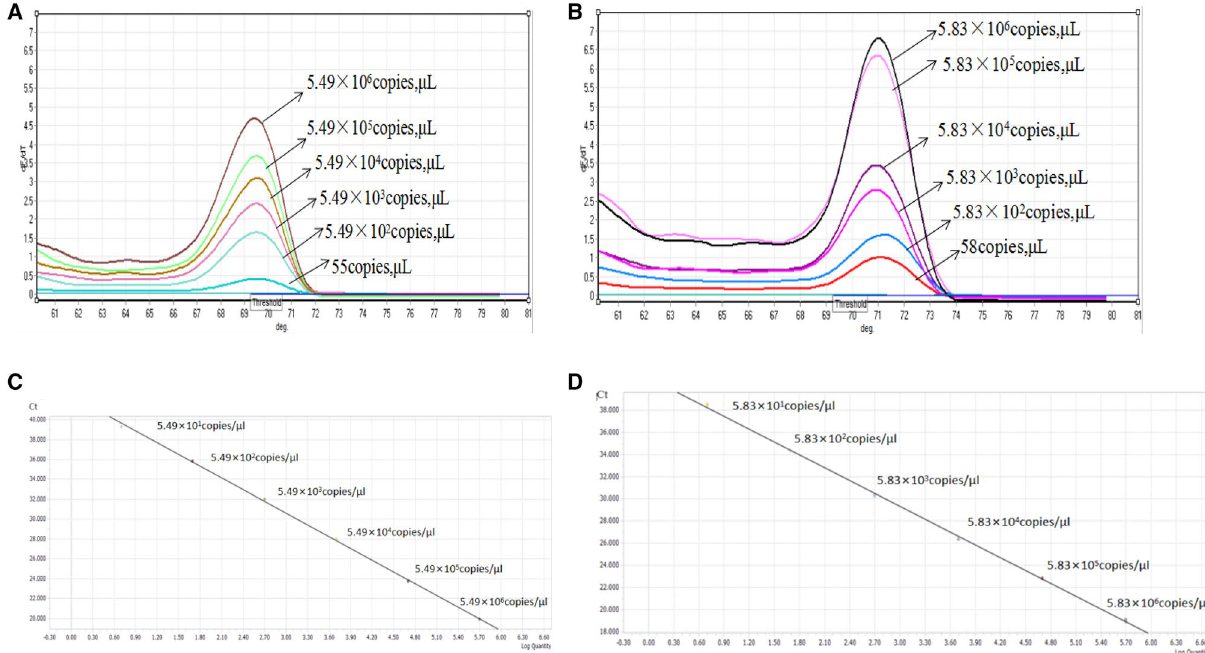
Figure 3. Sensitivity tests of the HRM method of Mccp and Mmc positive samples. The pictures are generated by Rotor Gene Q. ( A ) Sensitivity tests of the HRM method for Mccp ; ( B ) Sensitivity tests of the HRM method for Mmc . ( C ) Standard curve of Mccp performed in a linear graph with R 2 = 0.9972. ( D ) Standard curve of Mmc performed in a linear graph with R 2 = 0.9974.